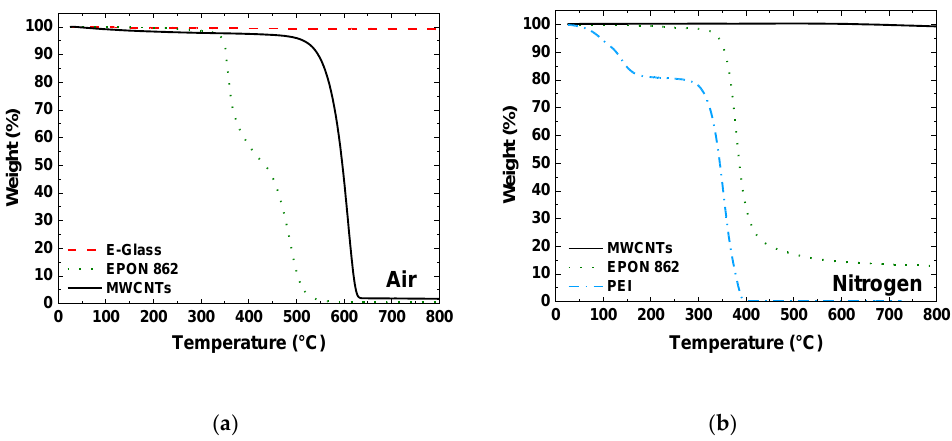
Figure 3. TGA thermographs of constituent materials in ( a ) air, showing decomposition of the epoxy and MWCNTs and minimal decomposition of the glass fiber, and ( b ) nitrogen, showing minimal decompositionoftheMWCNTs, completedecompositionofthePEIandaresidualmassofapproximately 13% for the EPON 862 epoxy resin.